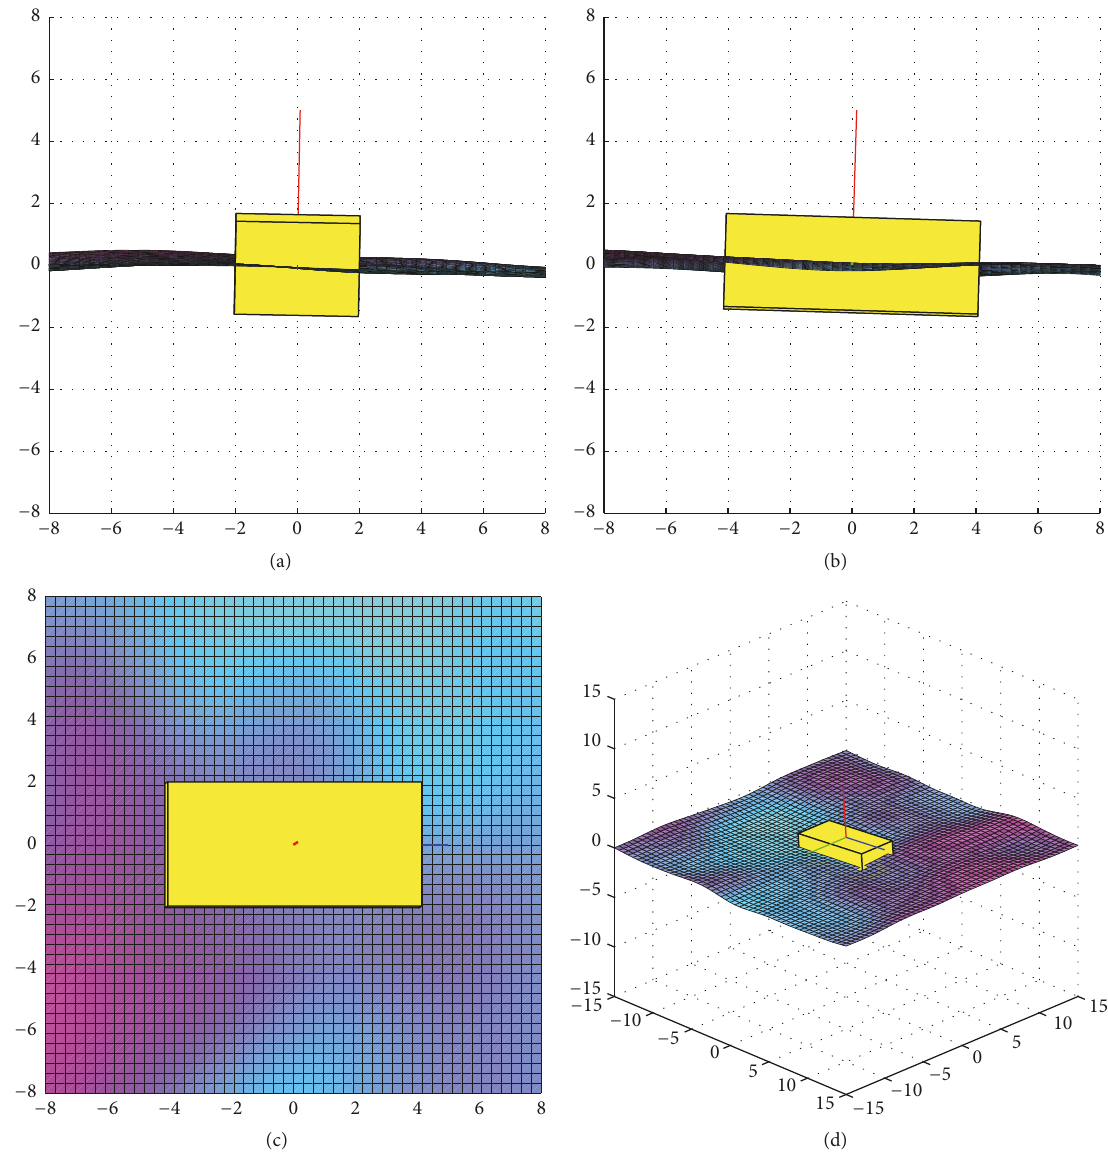
Figure 7: Estimation of six-DOF motion of USV with respect to the sea surface data by using RSM. (a) View of 𝑦 - 𝑧 plane direction; (b) view of 𝑥 - 𝑧 plane direction; (c) view of 𝑥 - 𝑦 plane direction; (d) view of azimuth = 45[ ∘ ] and elevation = 25 [ ∘ ].